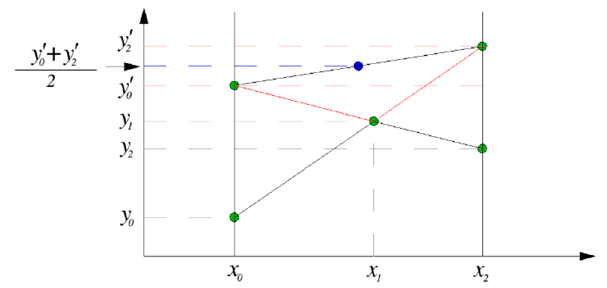
( ) / 2 y y ′ ′+ . Figure 6. Geometrical interpretation of the term ( y (cid:48) + y (cid:48) ) 2 0 2 0